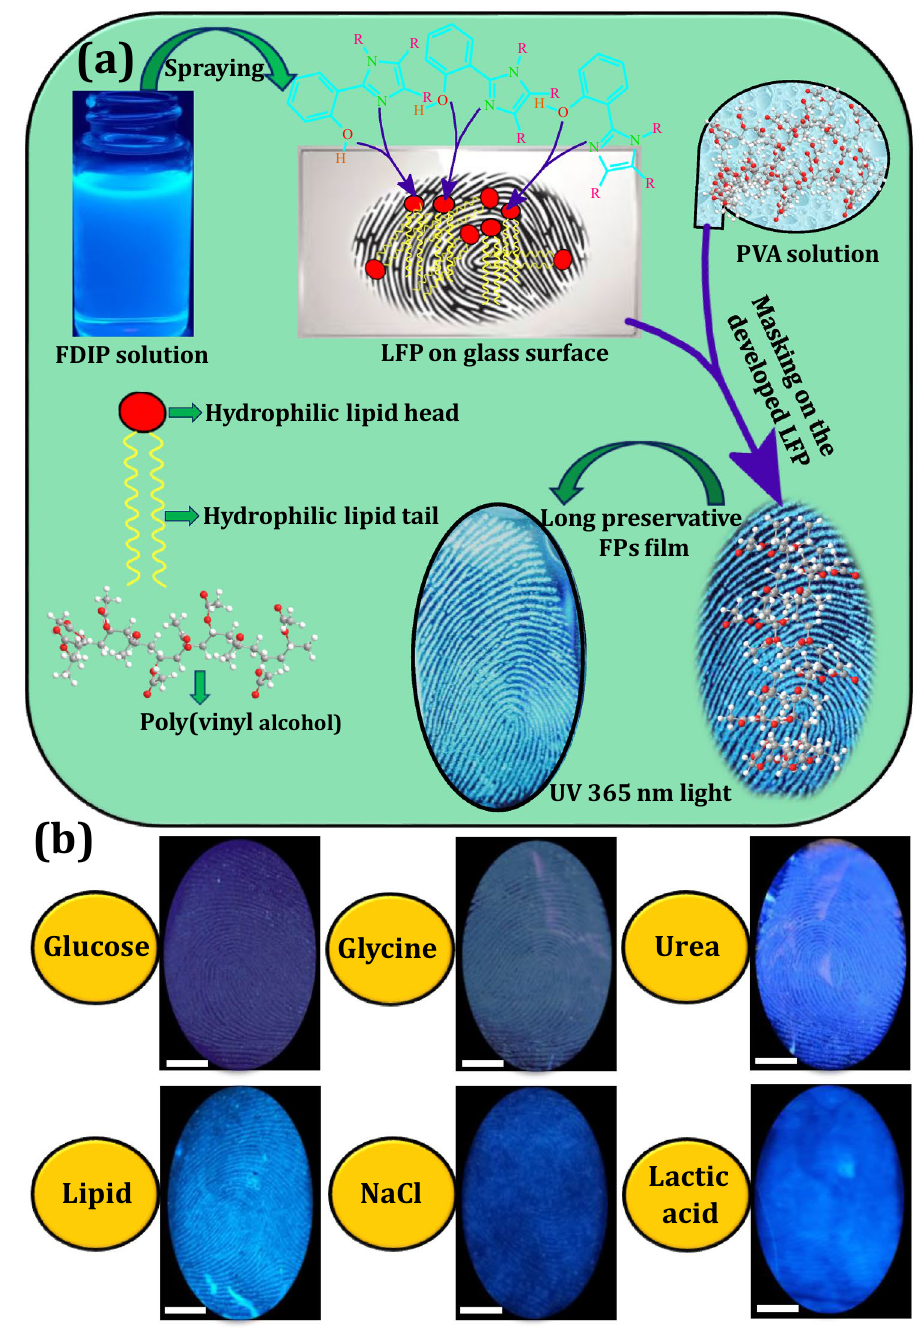
Figure 2. ( a ) Mechanism of LFPs visualization dynamics using FDIP solution; ( b ) RGB true-color FPs images developed on the glass surface soaked with glucose, glycine, urea, sodium chloride, lactic acid as well as lipids solutions under 365 nm light (Scale bar: 5